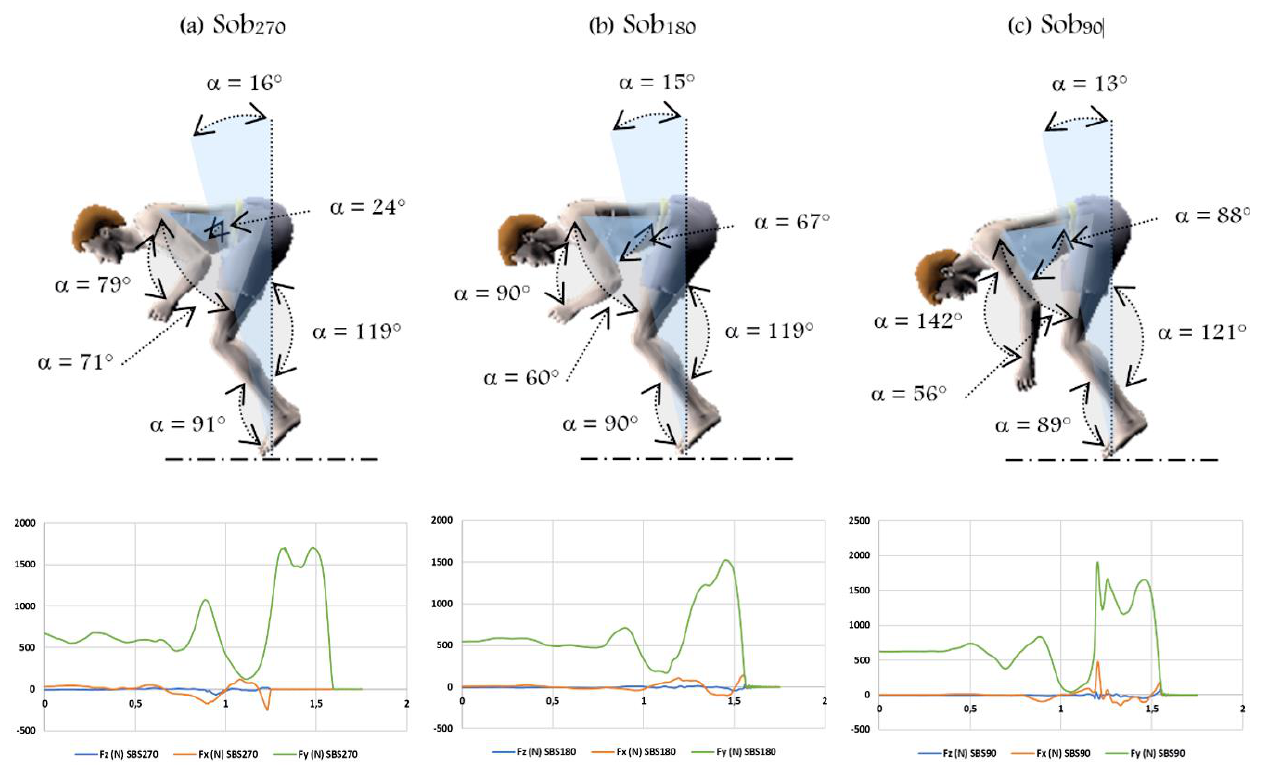
Figure 2. Examples of landing angles and ground reaction force during different standing back somersaults. ( a ) SBS 270 ◦ ; ( b ) SBS 180 ◦ ; ( c ) SBS 90 ◦